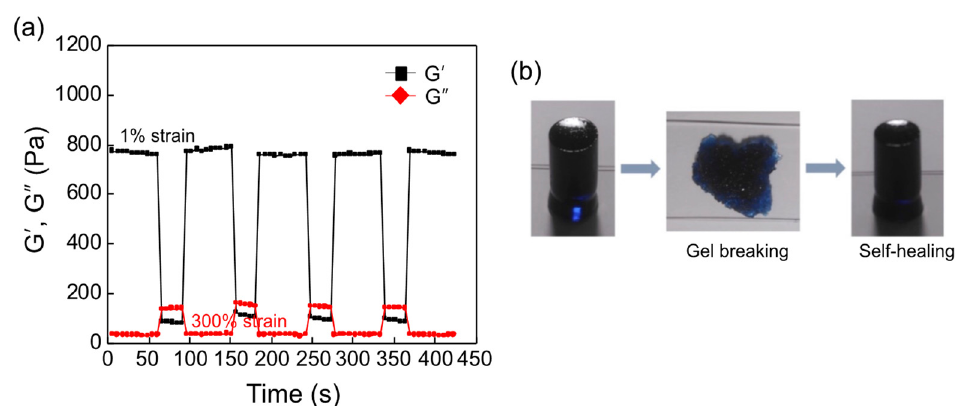
Figure 4. ( a ) The repeated self-healing behavior of OHA/GC/ADH/ALG hydrogels was confirmed by measuring the viscoelastic properties at 300% strain ([OHA] = 2 wt%, [GC] = 1 wt%, [ADH] = 0.3 wt%, [ALG] = 0.3 wt%). ( b ) Macroscopic observation of self-healing behavior of the gel using a cylindrical-shaped mold (5 mm diameter, 10 mm height). The gel was broken and placed into the mold, and mostly recovered its original shape within 10 min.